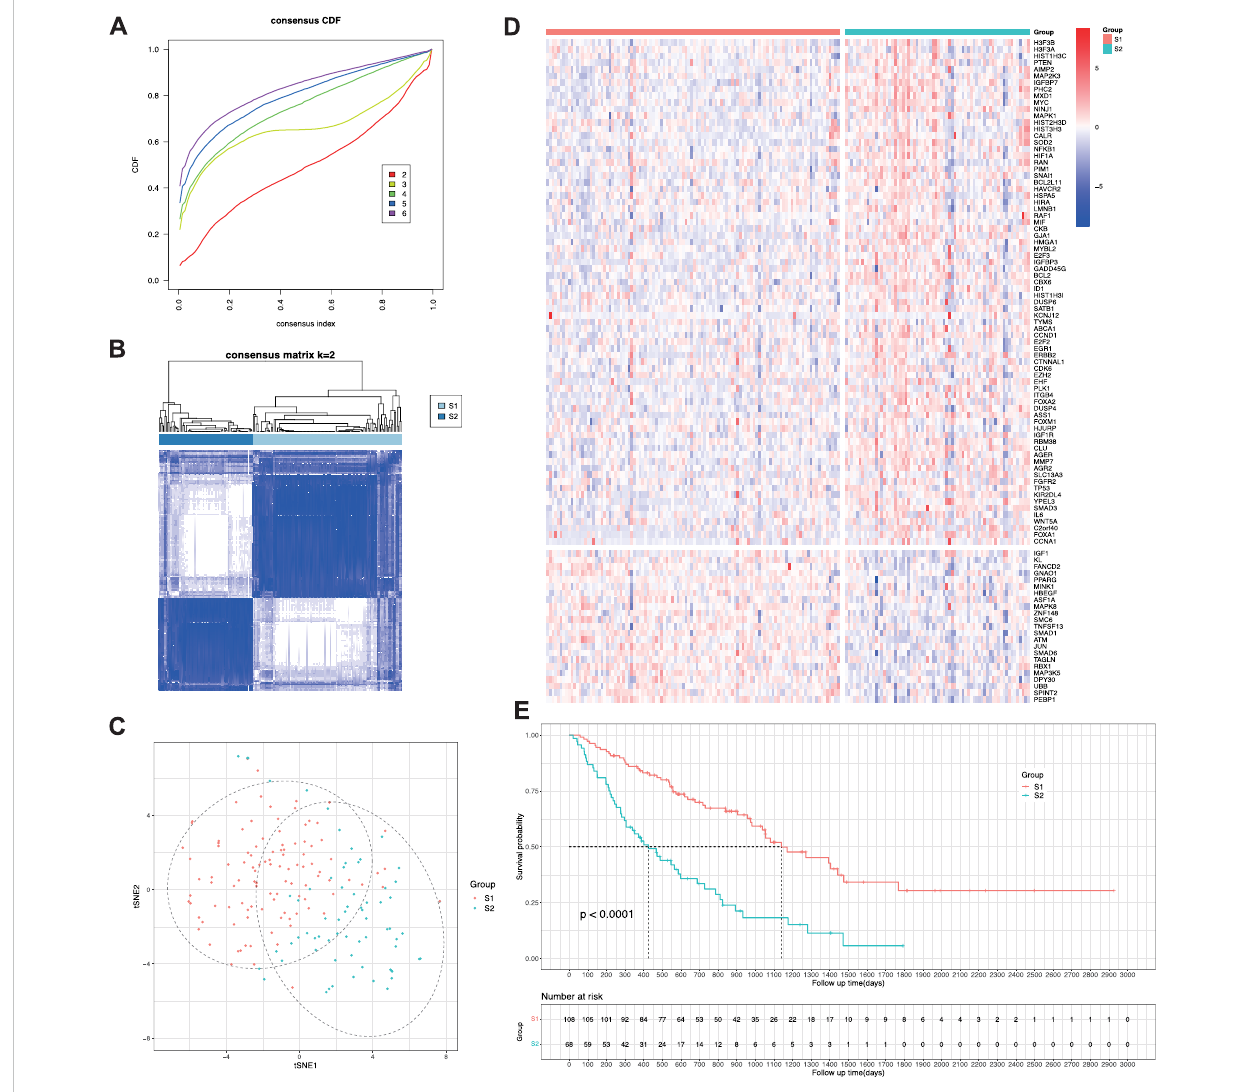
FIGURE 3 Identi fi cation of cellular senescence-related subtypes of IPF. (A) Cumulative distribution function curve. (B) Sample clustering heatmap. (C) t-SNE distribution of two subtypes. (D) Heatmap of two subtypes based on prognostic cellular senescence-related genes. (E) Kaplan-Meier curves showing overall survival of two